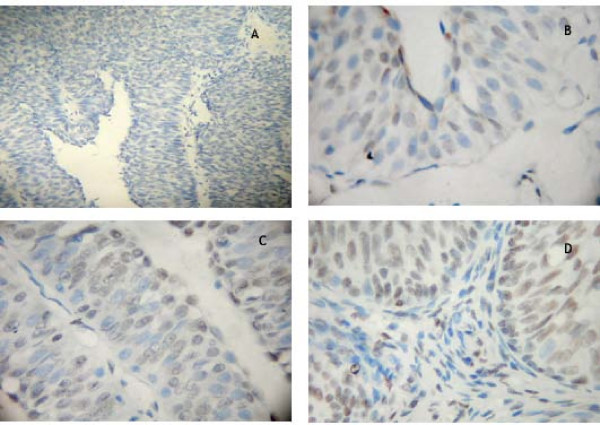
Expression analysis of Bmi-1 protein by immunohistochemistry. Bmi-1 staining was mainly localized within the nuclei, and it expressed was observed in cancer cell. A: Negative Bmi-1 staining in non-cancerous tissue (100×). B: Weak Bmi-1 staining in non-cancerous cells(400×). C: strong Bmi-1 staining in tumor nests(400×). D: Strong nuclear stainingin most of the tumor cells (400×).